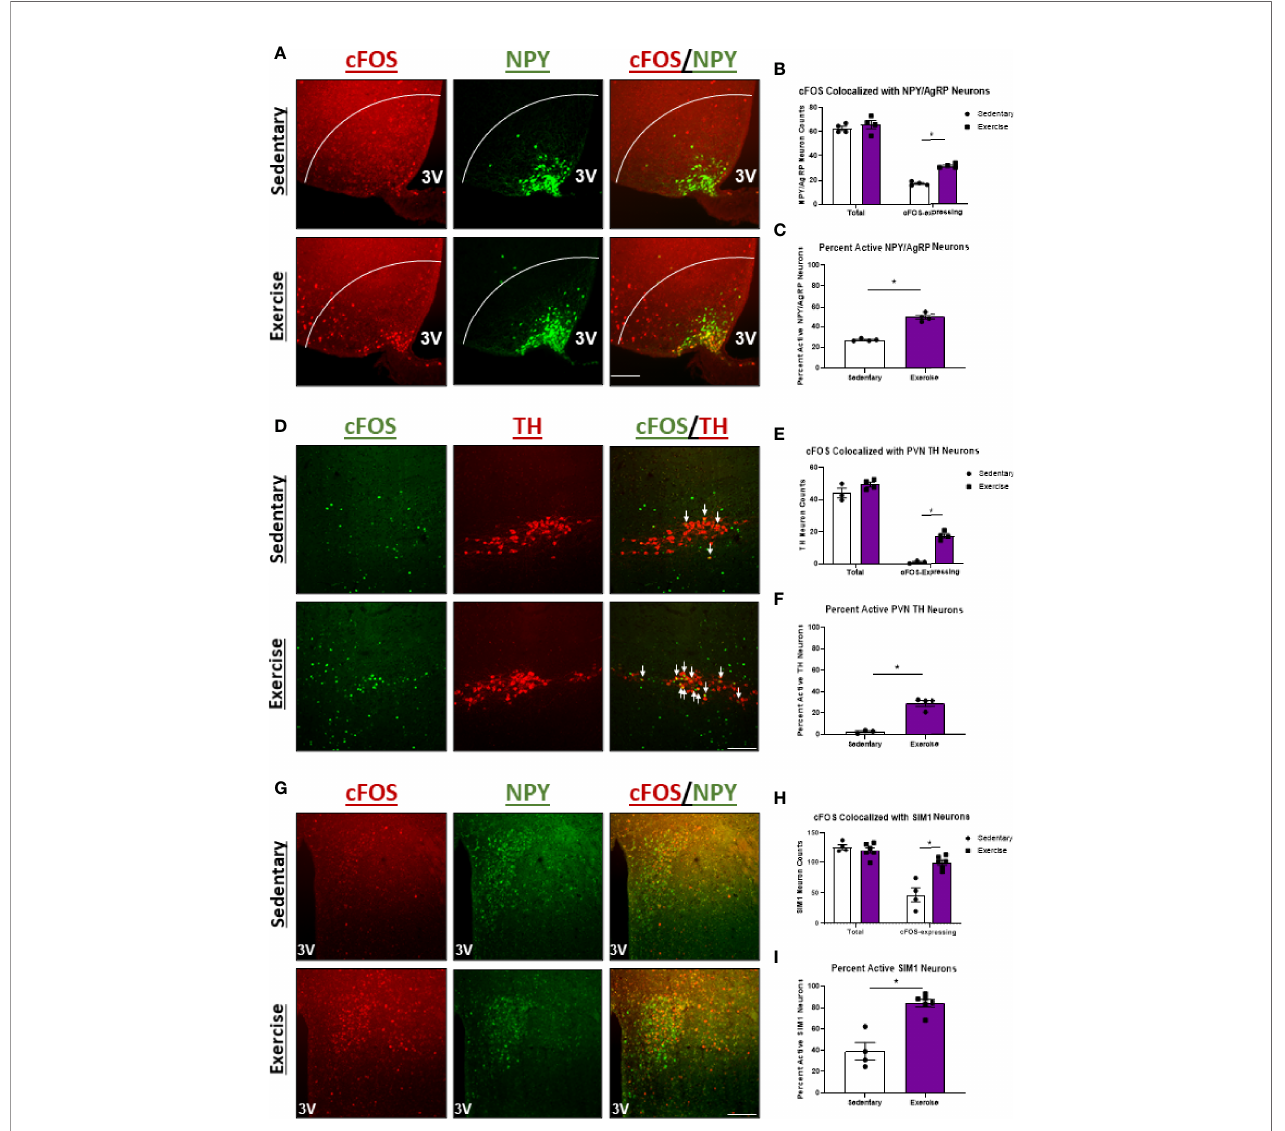
FIGURE 5 | Regardless of energy status, high intensity treadmill exercise increases NPY/AgRP ARC , TH PVN , and SIM1 PVN neuron activity. (A) Representative images of cFOS (red) colocalized with NPY/AgRP ARC neurons (green) in male mice 1 hour after sedentary trials or high intensity treadmill exercise. (B) Total and cFOS- expressing NPY/AgRP ARC neurons and (C) Percent active NPY/AgRP ARC neurons (n=4/group). (D) Representative images of cFOS (green) colocalized with TH PVN neurons (red) in fed male mice 1 hour after sedentary trials or high intensity treadmill exercise. (E) Total and cFOS-expressing TH PVN neurons and (F) Percent active TH PVN neurons (n = 3-4/group). (G) Representative images of cFOS (red) colocalized with SIM1 PVN neurons (green) in fed male mice 1 hour after sedentary trials or high intensity treadmill exercise. (H) Total and cFOS-expressing SIM1 PVN neurons and (I) Percent active SIM1 PVN neurons (n = 4-6/group). 3V, Third ventricle; Scale bar = 50um. Data represented as mean ± SEM. *indicates p < 0.05 vs. sedentary